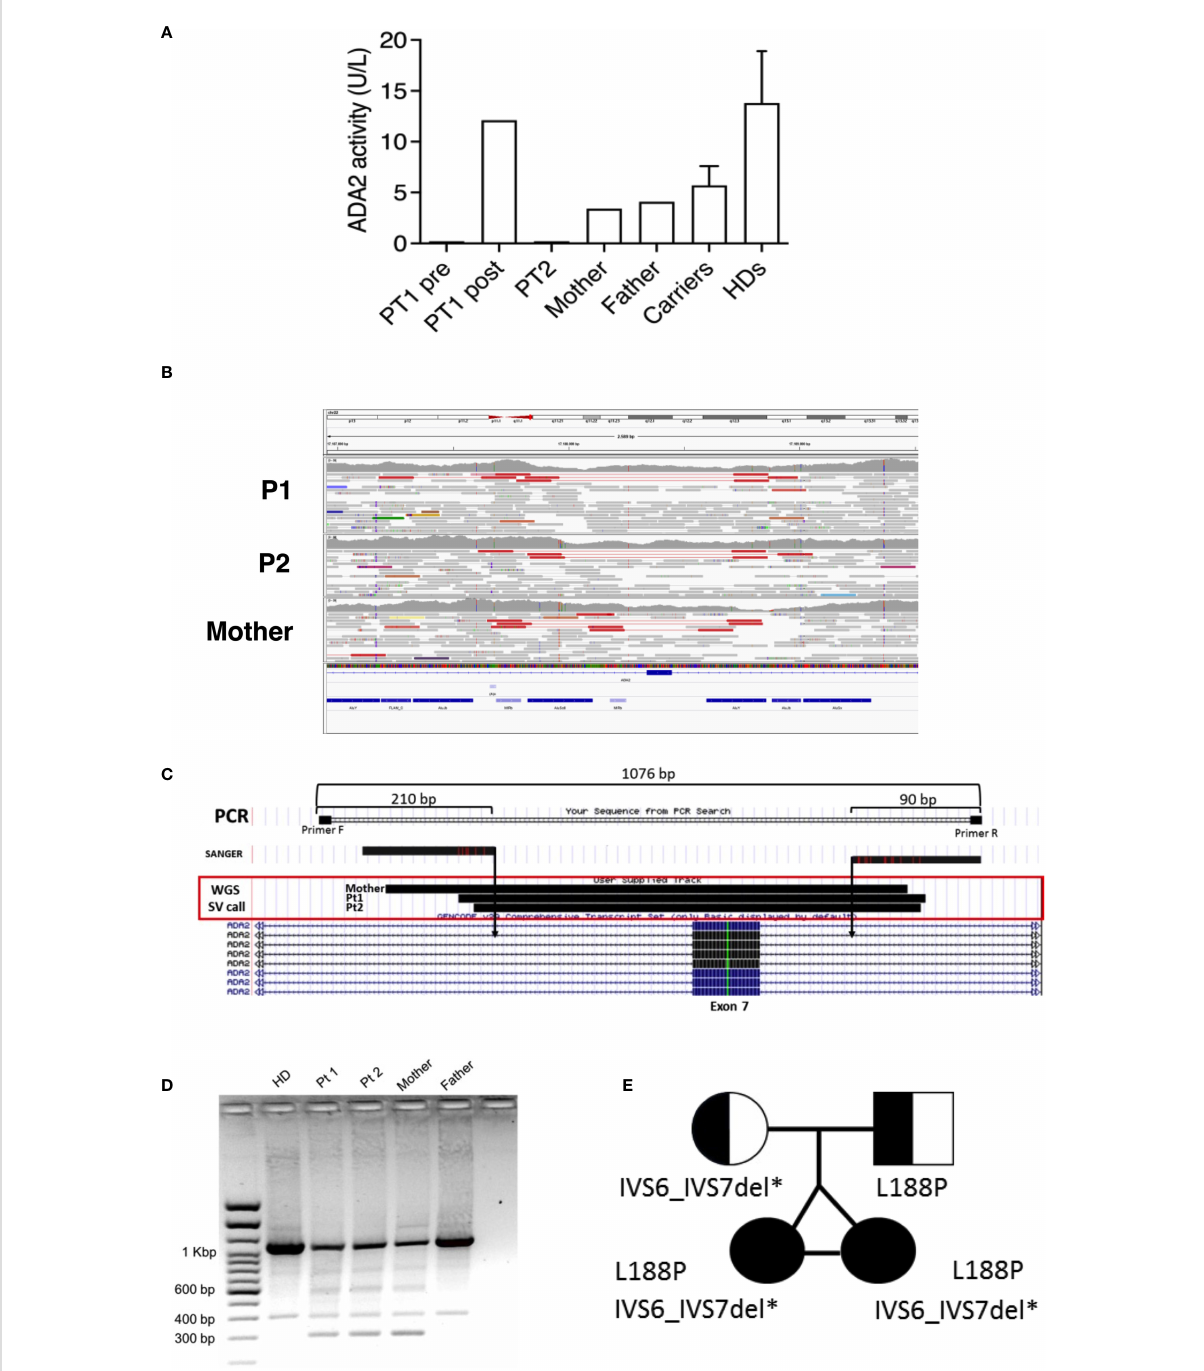
FIGURE 3 (A) ADA2 plasmatic activity in P1 (before and after HSCT), P2, parents, carriers (n= 46), and healthy controls (n=27). (B) Visualization of mapped reads (as pairs) with Integrative Genomics Viewer (IGV) around the ADA2 exon 7. The tracks related to P1, P2, and the mother are depicted from top to bottom. On the top of each track, pairs (in red) spot the deletion event. Reads colored in grey represent properly mapped paired-end reads. (C) Graphical representation of PCR ampli fi cation used for validating the deletion. (D) Short amplicons of 300 bp visualized by agarose gel electrophoresis in P1, P2, and the mother. (E) Pedigree of the affected twin sisters, compound heterozygous for the missense mutation L188P and IVS6_IVS7 deletion in the ADA2